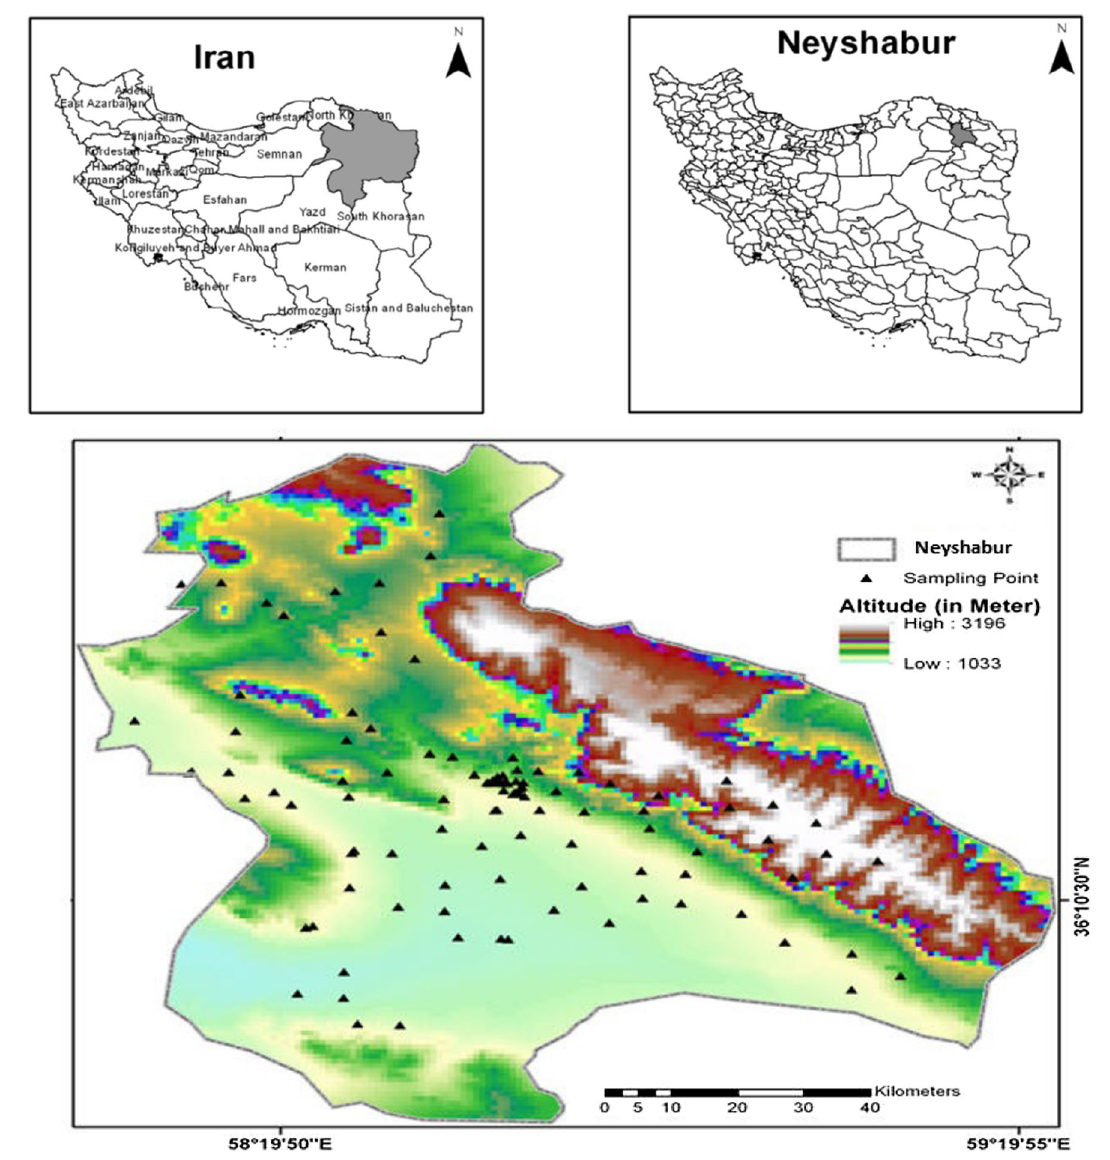
Fig. 1 Location of the study area and sampling of groundwater